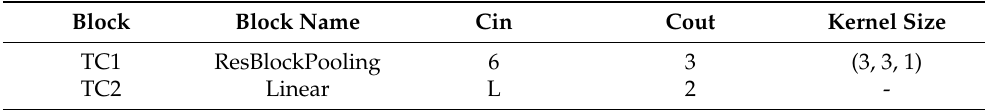
Table 1. The architecture of the temporary classifier. After the pooling layer, the tensors are reshaped to (batch, L) size. The value of L is different for the long-axis and short-axis views. Block Block Name Cin Cout Kernel Size TC1 ResBlockPooling (3, 3, 1) TC2 Linear